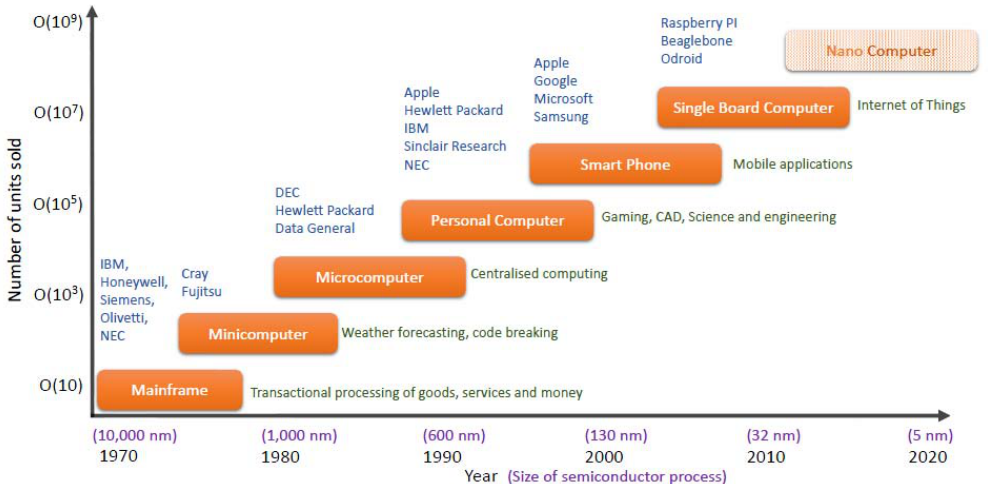
Figure 1. Centralised (Mainframe) processing was state of the art, which evolved to be smaller (Minicomputer and Microcomputer) and more personal (Personal Computer) over the decades. As the usage patterns changed, the cost dropped, and computing became more mainstream and accessible, even extending into mobile platforms (Smart phones). The Single Board Computer, spurred by the popularity of Internet of Things devices is the current trend, selling tens of millions of units. We predict this will be the basis for the next generation of commodity device whose cost and accessibility will result in billions of